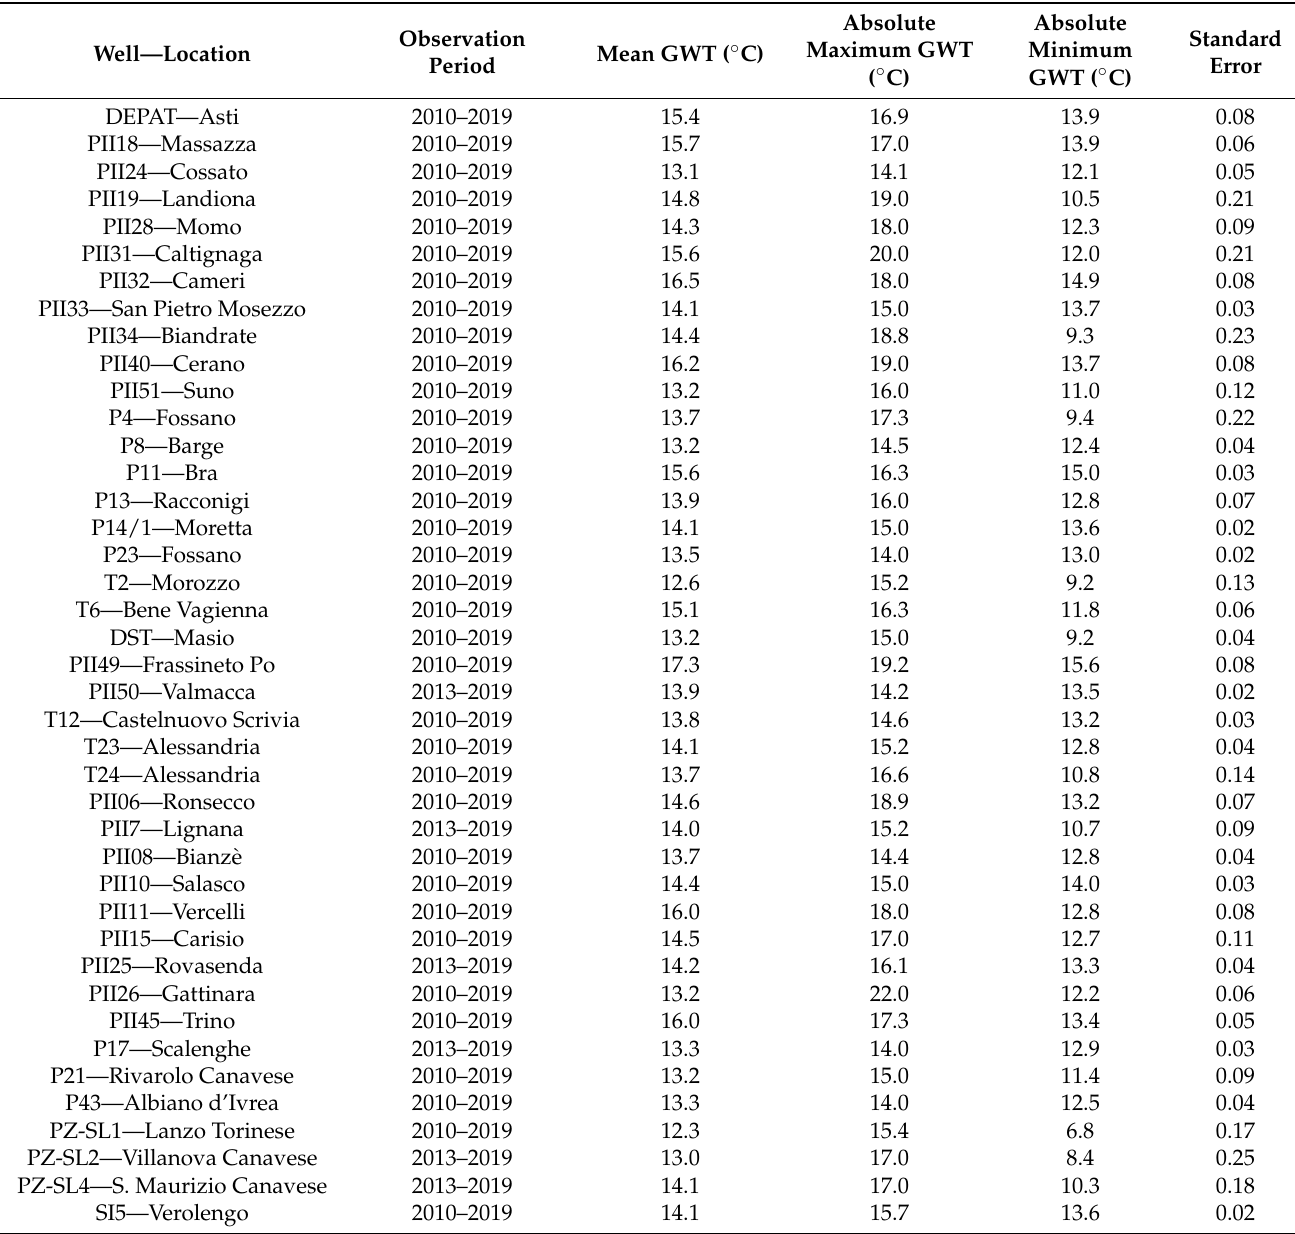
Table 1. Summary of monthly mean statistical data for GWT (mean, mean absolute maximum, mean absolute minimum and standard error) for the observed monitoring wells.